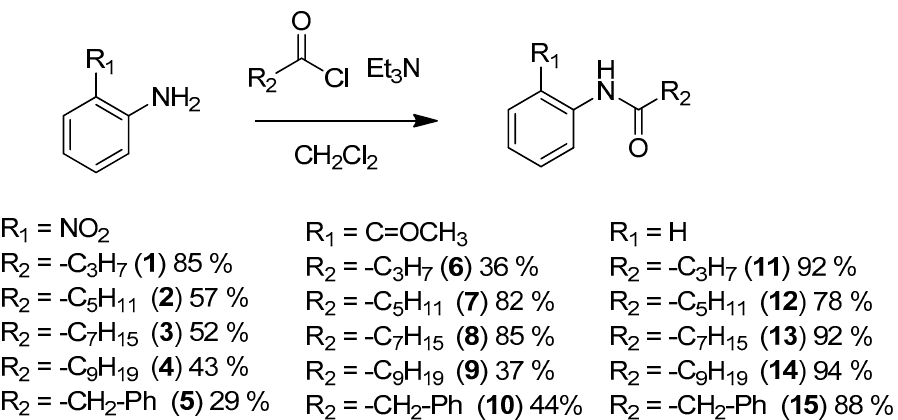
Figure 4. Synthesis and structure of acyl aniline derivatives as LuxR modulators.